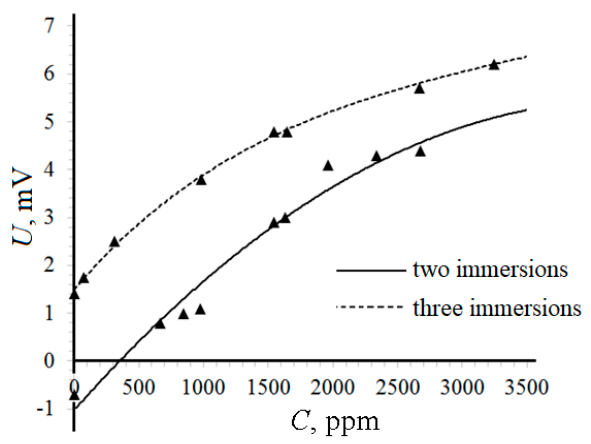
Figure 4. Concentration dependence of the electromotive force for the ZnO/ZnO–Cu samples ( T = 300 ° С ).